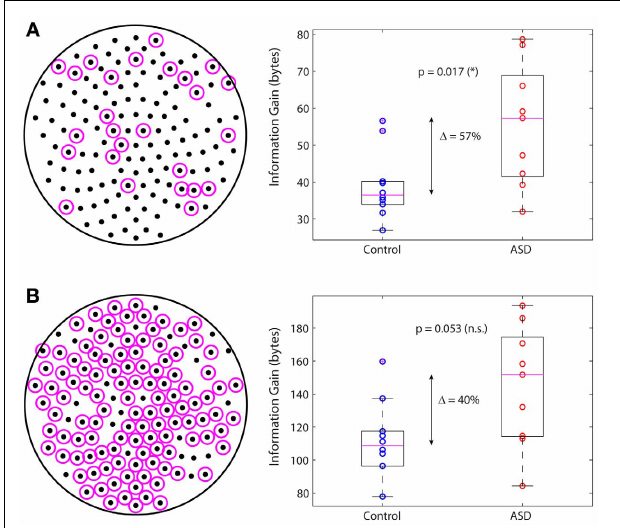
FIGURE 5 | Main subnetwork contributing to the increased information gain. (A) Subnetwork containing the largest (in absolute value) and most significant changes in functional connectivity (left). This subnetwork alone accounts for a significant increase in information gain in autism (right). (B) Complementary subnetwork containing the remaining sensors (left). This subnetwork cannot account for the change in information gain on its own, as the increase is not statistically significant